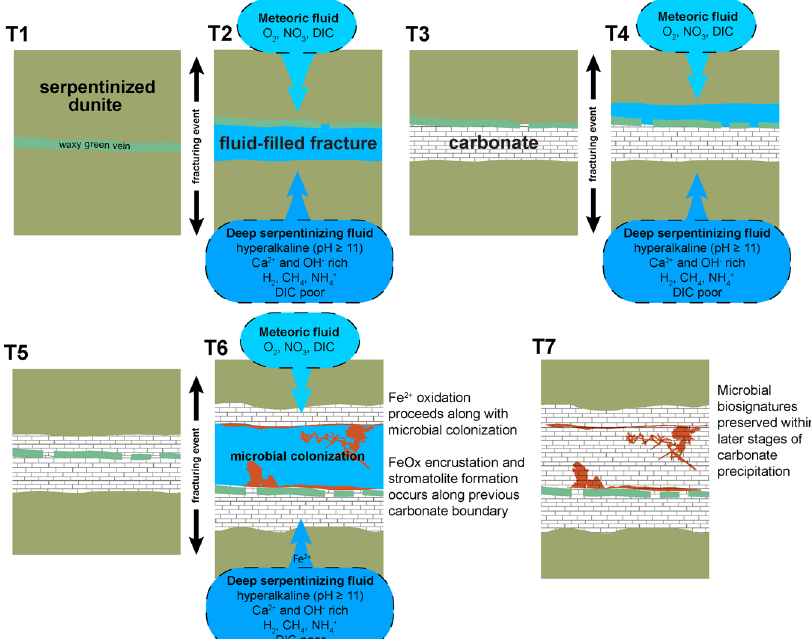
Fig. 5 Conceptual model of biosignature preservation in serpentine-hosted carbonate veins. Time 1 (T1) begins with serpentinized ultrama fi c host rock, followed by a brittle fracturing event (T2) resulting in fl uid fl ow via adjoining connective fractures (represented by blue arrows above and below). Where deep hyperalkaline & reduced serpentinizing fl uids rich in Ca and poor in DIC contact shallow meteoric fl uids containing DIC, carbonate precipitation occurs resulting in sealing of the fracture (T3). Crack-and-seal style fracturing continues (T4 – T6), with remnant material (e.g., preexisting “ waxy green ” serpentine vein) entombed within the carbonate. At T6, iron oxidation proceeds along with microbial colonization within the fracture space. When carbonate saturation is reached within the fracture space, another stage of precipitation occurs (T7) resulting in fossilization of the in situ microbial